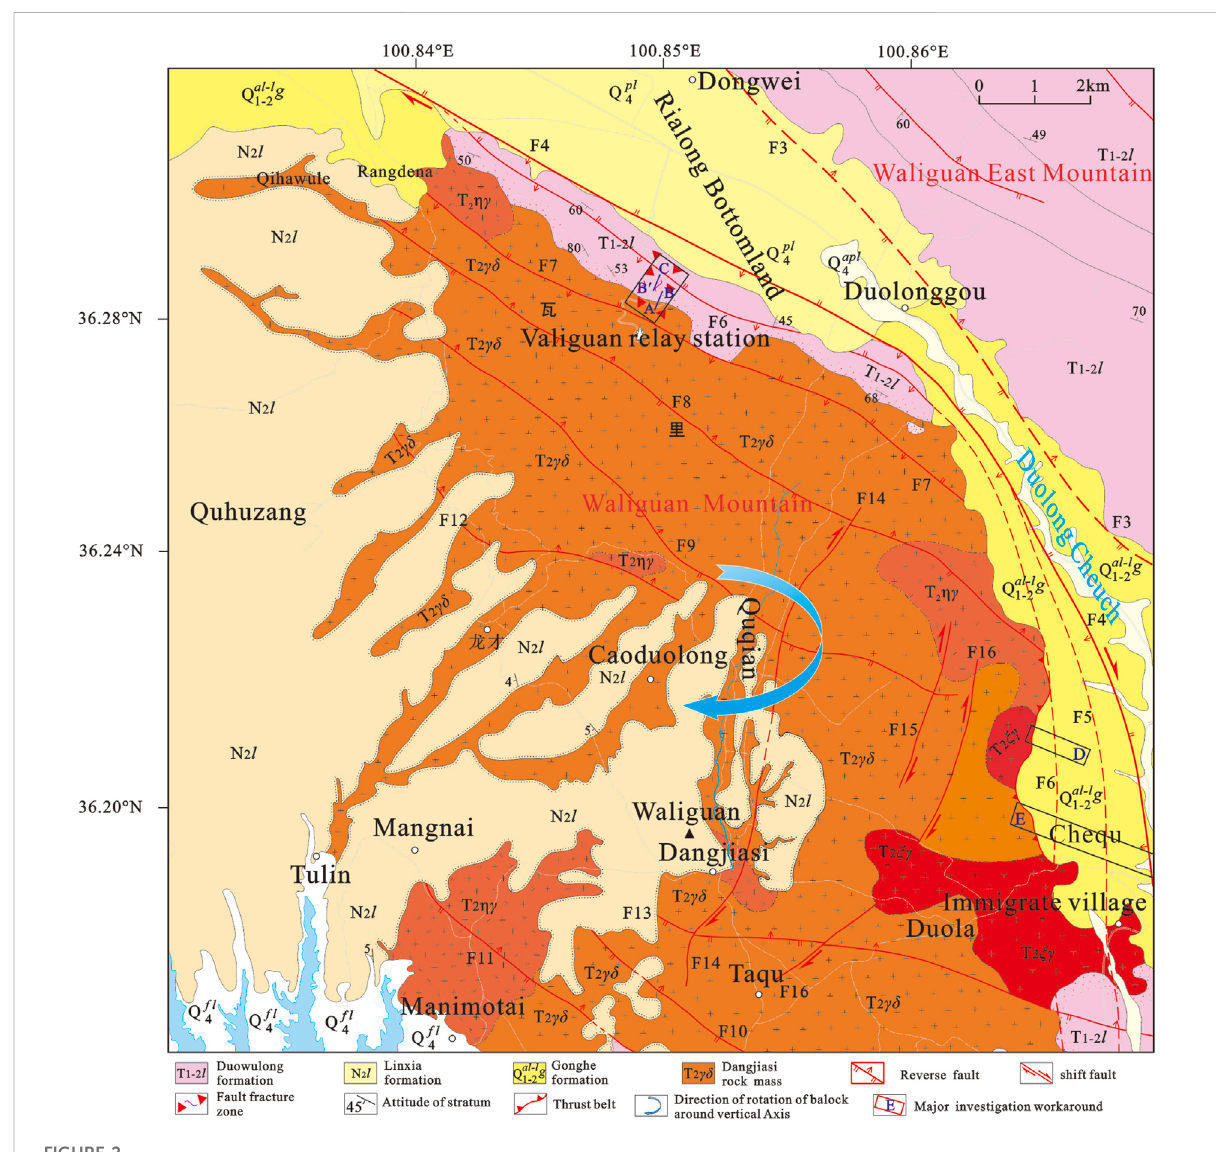
FIGURE 2 Geologic map of the thrust nappe at Waliguan Mountain (Area A in Figure 1B) (Chen et al., 2016).